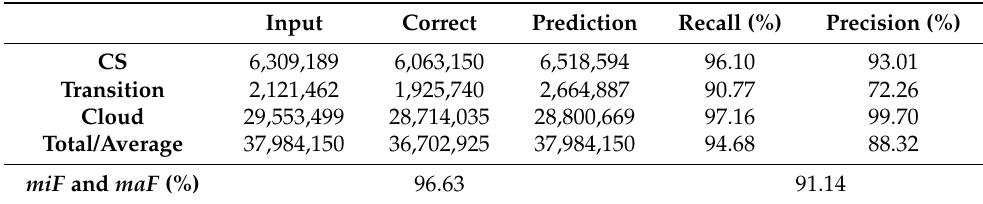
Table 3. Summary of evaluation of three CSM types in nighttime, 21 February 2020.